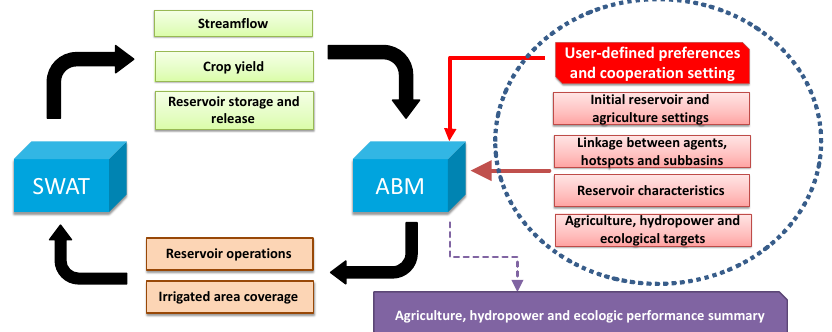
Figure 1. Overview of the modeling framework coupling ABM with